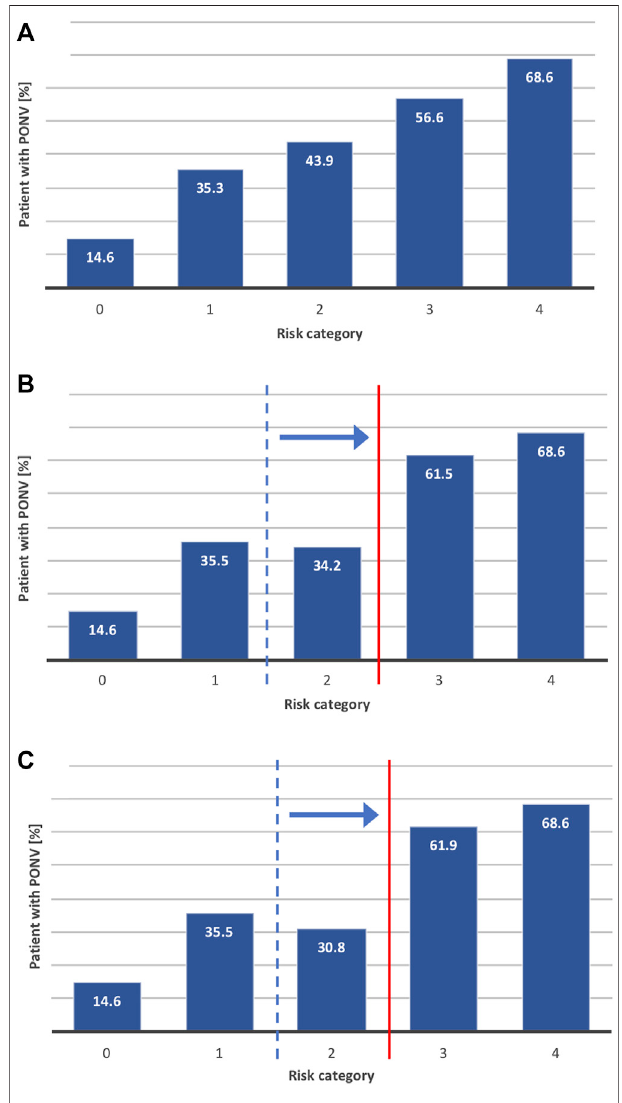
FIGURE 4 | Integration of HTR 3B rs3782025 genetic information in prediction score modeling. We tested three different models to evaluate the potential impact of integrating HTR 3B rs3782025 genotype in the prediction score. The fi gures shows the proportion (%) of patients predicted to suffer from PONV in each risk category of (A) classic risk score (Apfel score) without genetic information (B) Apfel score + rs3782025 genotyping for women below 50 years of age in Apfel score category 2 (C) Apfel score + rs3782025 genotyping for all women in Apfel score category